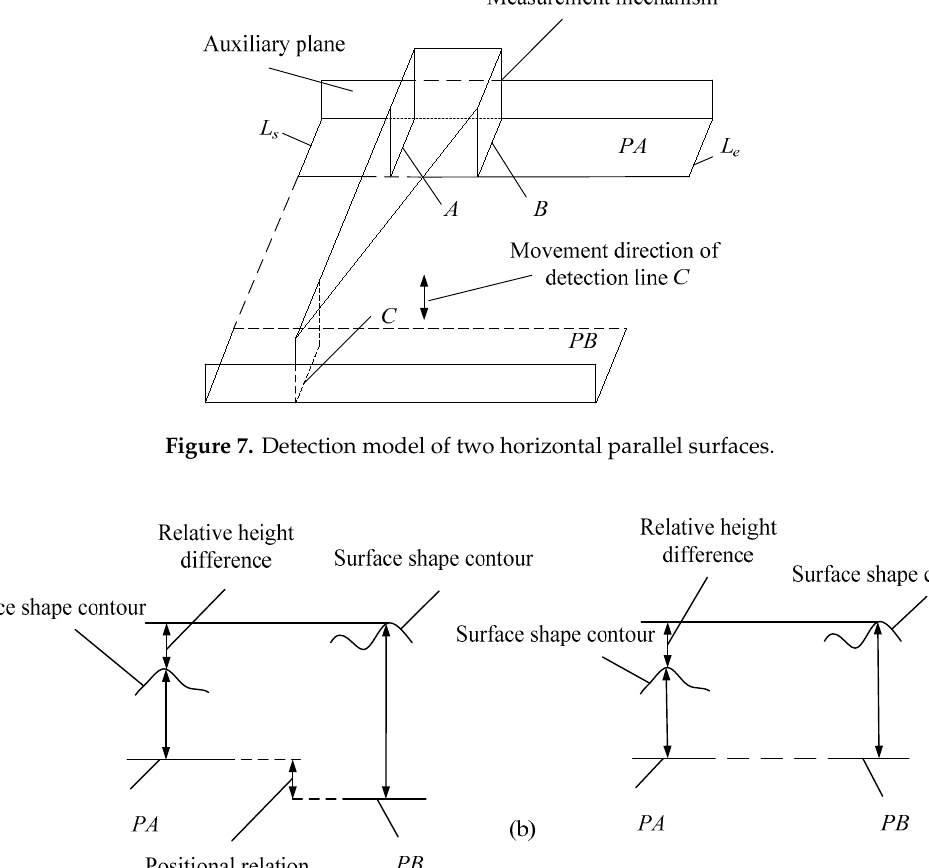
Figure 9. Detection model of two vertical parallel surfaces.